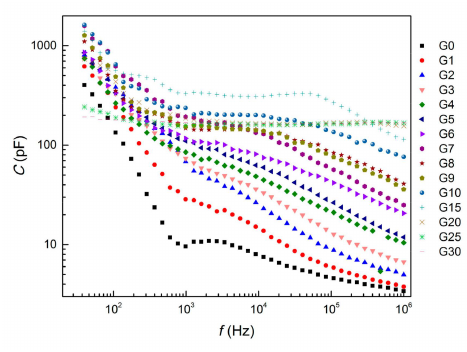
Figure 8. Electrical capacitance of AAS composites with 0 wt%–30 wt% of graphite powder as a function of frequency.